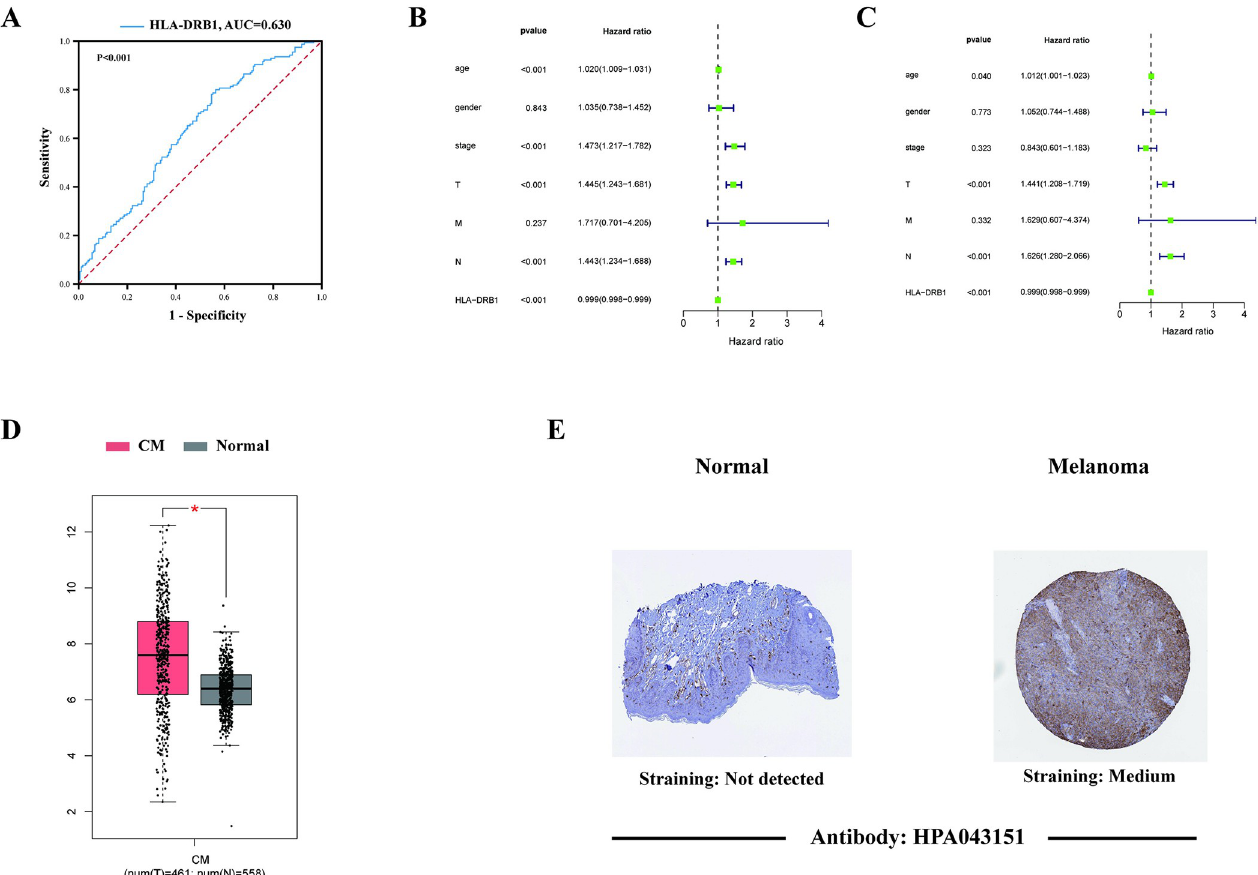
Fig 7. ROC curves, independent prognostic analysis and the validation of the expression level of HLA-DRB1. (A) The ROC curve of the expression level of HLA-DRB1. (B, C) The results of univariate and multivariate Cox regression analysis. (D) The box plot displayed the expression level of HLA-DRB1 in the melanoma and normal skin samples from the TCGA and GTEx databases based on the GEPIA web server. (E) The representative immunohistochemical images of HLA-DRB1 in the normal skin tissue and melanoma tissue from the Human Protein Atlas (HPA)